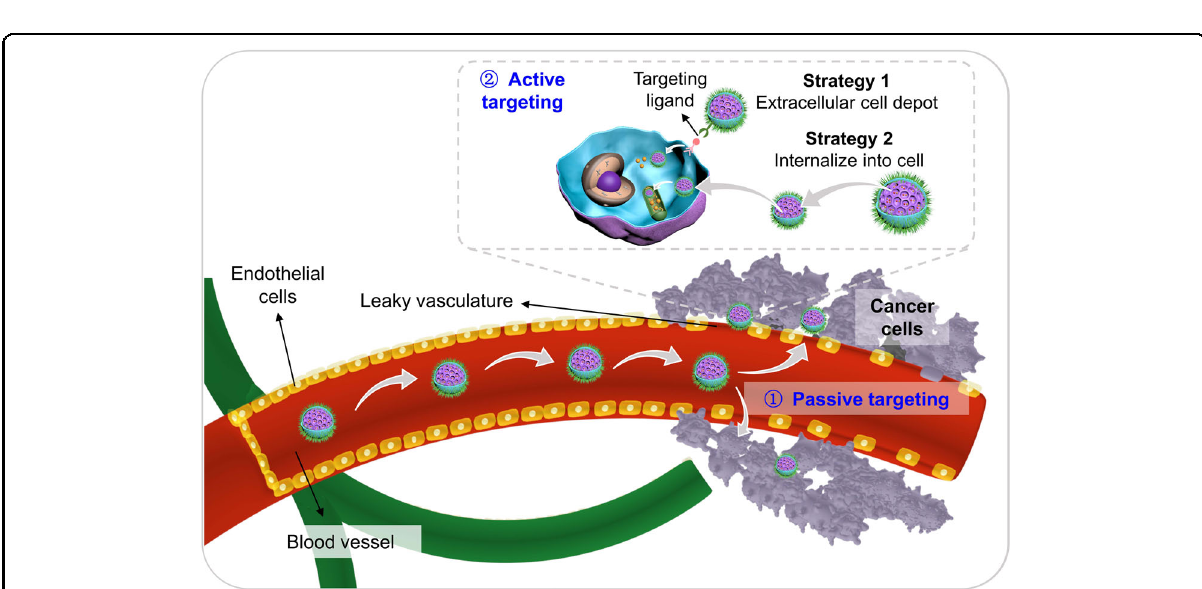
Fig. 15 General uptake pathways of passive and active targeting, which ultimately determine mesoporous fate after administration. Passive targeting takes advantage of enhance permeation effect and abnormal tumor physiology. In passive drug delivery system, nanoparticles can be modi fi ed by modifying their size, shape, and surface charge. Active targeting inroduces targeting moiety onto the nanoparticle system to improve speci fi city in cancer cells, both extracellular and